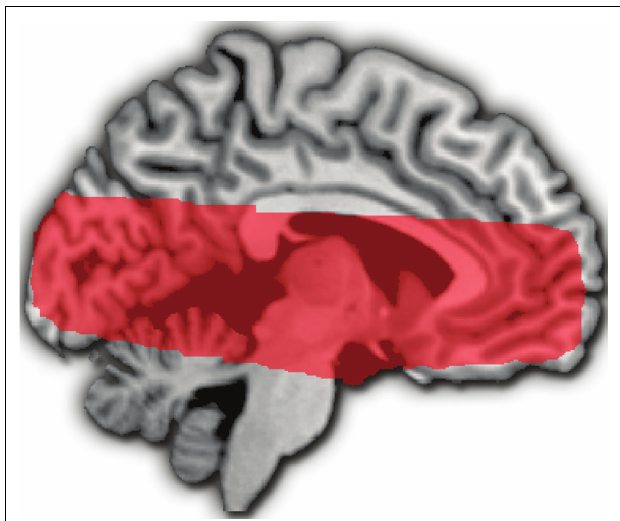
FIGURE 2 | Medial surface sagittal image showing overlap of fMRI volumes acquired in the 17 included participants.